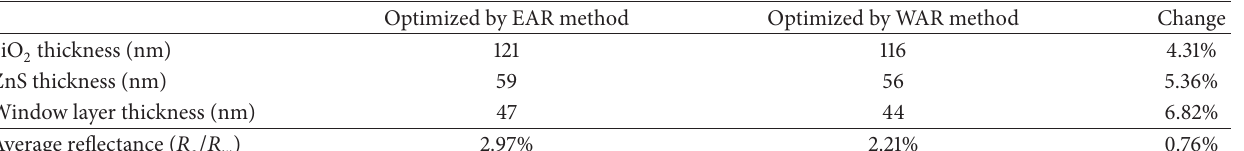
/ZnS ARC for triple junction SC optimized by different methods. 2